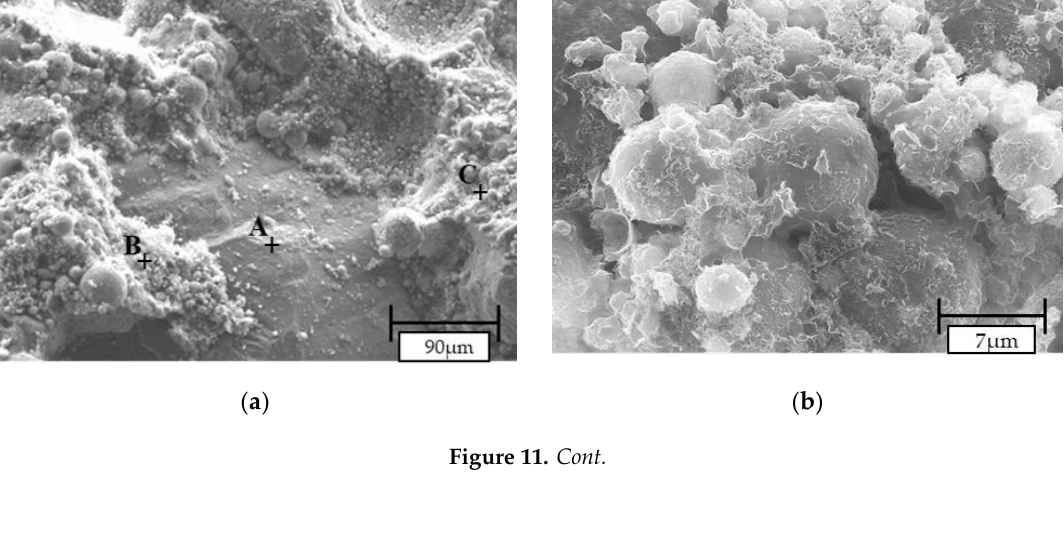
( f ) Figure 11. SEM pictures of mortars alkali-activated with N5-C10: ( a , b ) RFA, CFA ( c , d ), and BFA ( e , f ). *A—aggregate, B—interface between gel and aggregate, C—aluminosilicate/geopolymer paste, and D—microcracks. 4. Conclusions The influence of the activator type on the formulation of modified fly ash based geopolymer mortars was studied on different fly ashes. Based on the results, key findings can be drawn.  Mortars activated with NaOH and Sodium Silicate (N5-S22) and NaOH with CaO (N5-C10) induced the highest flexural and compressive strengths for all the AAM. At 28 days,